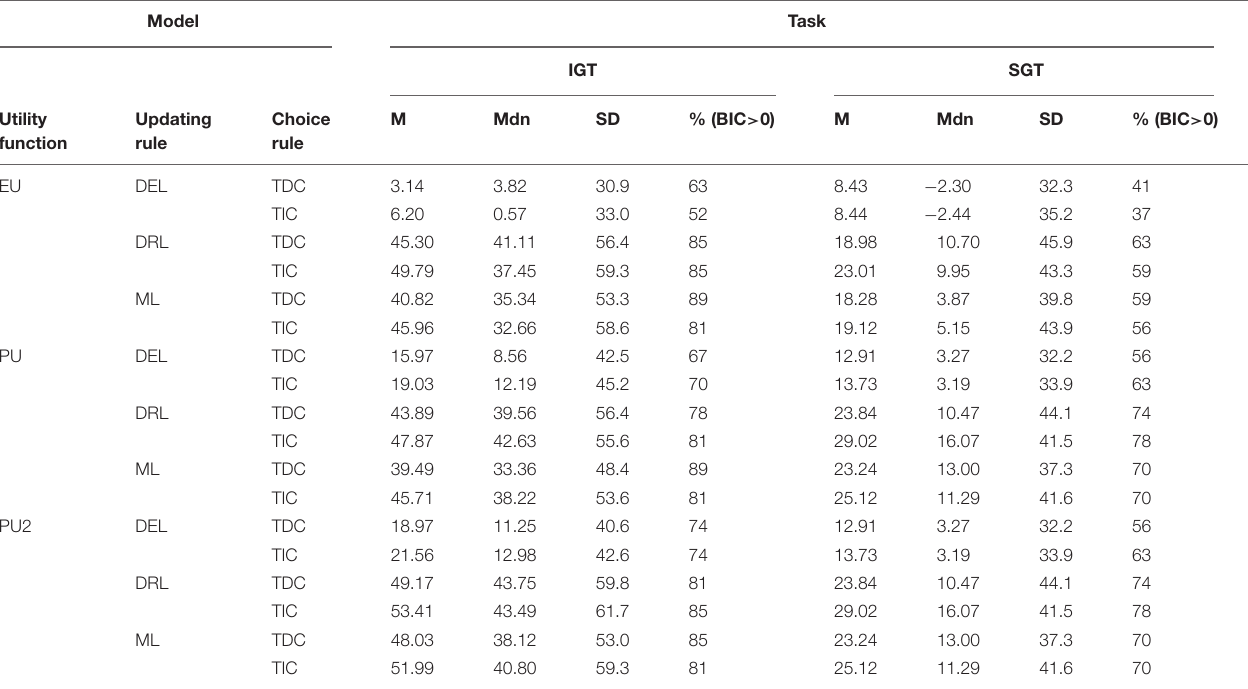
TABLE 5 | Summary of BIC difference scores of the 18 cognitive models relative to the baseline statistical model in the IGT and SGT among controls. Model